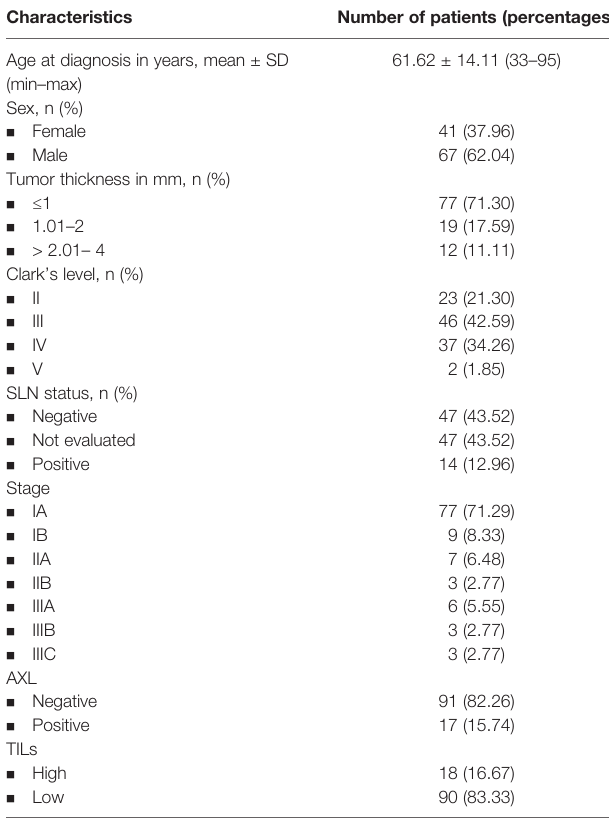
TABLE 2 | Patients ’ clinicopathological characteristics. Characteristics Number of patients